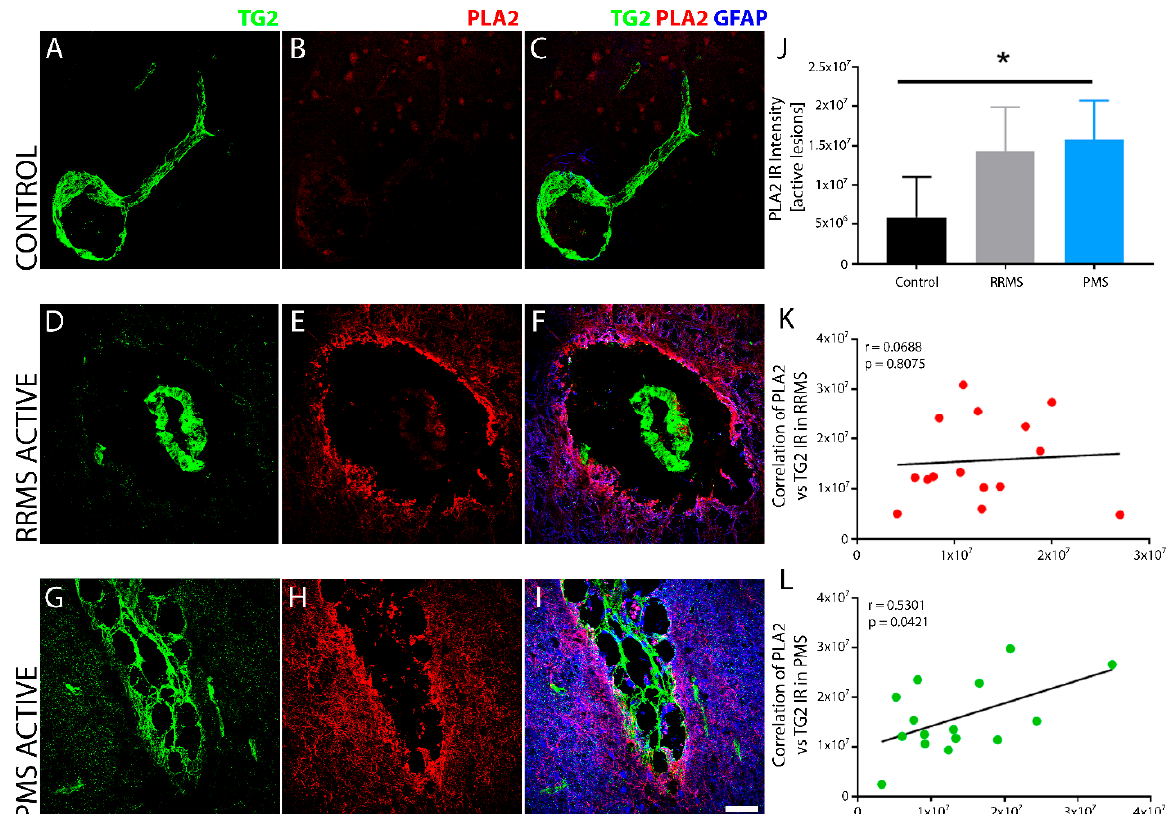
Figure 9. Lesions show increased phospho-PLA2 Ser505 immunoreactivity in brain tissue with TG2 after PMS. pPLA2 Ser505 levels were elevated with an increase in the expression of TG2 in active lesions after PMS. Most of the PLA2 immunoreactivity was found in the lesion edge, while being absent in the lesion core. The non-MS control brain tissue ( A – C ) did not show pPLA2 Ser50 IR ( B , C ) compared to brain tissue after RRMS ( D – F ), which showed only modest increase in the levels of pPLA2 Ser50 ( E , F ) compared to the control tissue. Sclerotic lesions after PMS ( G – I ) exhibited a robust increase in pPLA2 Ser50 ( H , I ) expression. Quantitative assessment of pPLA2 Ser50 immunoreactivity indicated significant upregulation in the levels of pPLA2 Ser50 only after PMS ( J ). Scale bar = 50 µ m. Data were quantified and expressed as value of the mean plus the standard deviation (SD). Statistical significance indicated a * p < 0.05, determined using a 1 ‐ way analysis of variance and post hoc Tukey test. pPLA2 Ser50 expression showed a significant positive correlation with TG2 IR in active lesions only after PMS ( L ) and not after RRMS ( K ). The correlation between the expression levels of pPLA2 Ser50 and TG2 IR in the lesions from all the patients in each of the two forms of MS is shown in ( K , L ). The p ‐ value determined by linear regression and Pearson correlation coefficient (r) is indicated for each of the analyses.